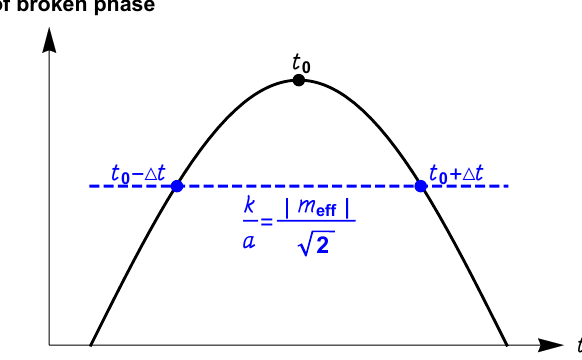
Figure 3 . Two resonances around a maximally symmetry broken